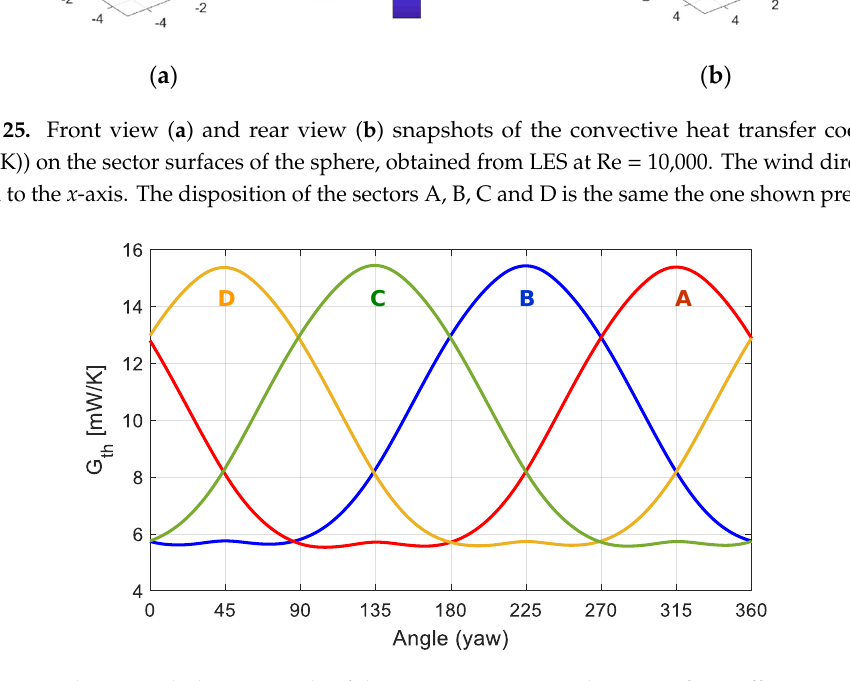
Figure 25. Front view ( a ) and rear view ( b ) snapshots of the convective heat transfer coefficient (W/(m 2 K)) on the sector surfaces of the sphere, obtained from LES at Re = 10000. The wind direction is parallel to the x -axis.